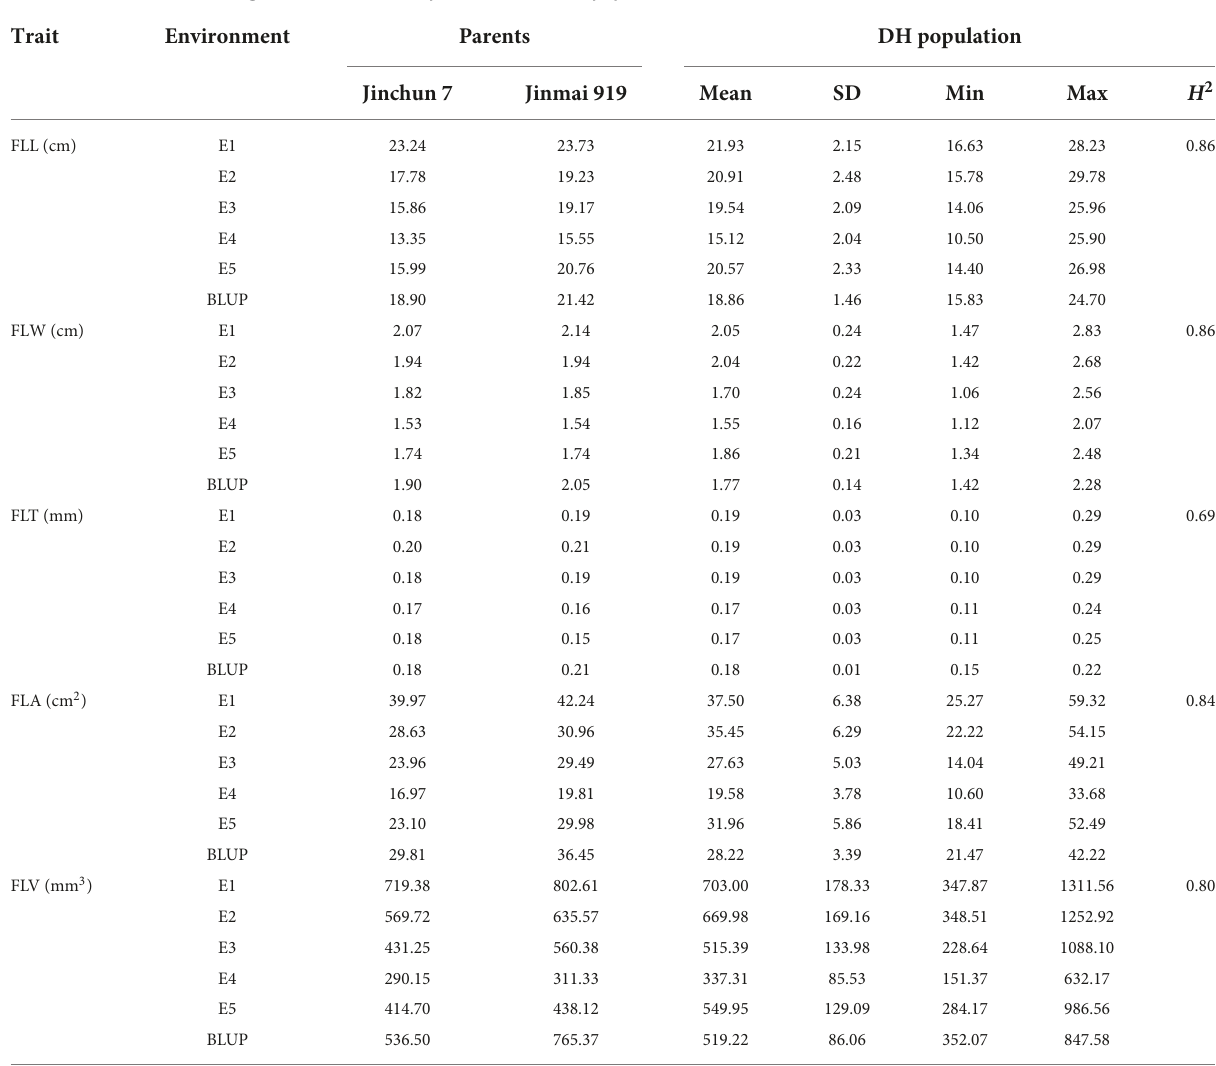
TABLE 2 Measurement of flag leaf-related traits in parents and the DH population.